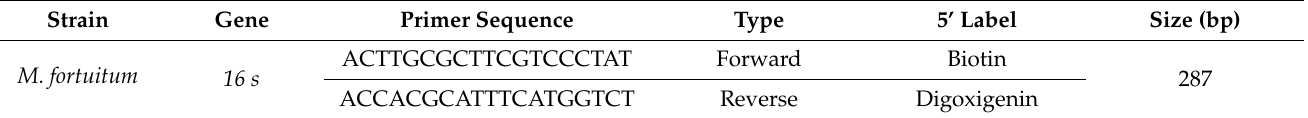
Table 1. Sequences of the set of primers for the double-tagging PCR amplification for the detection of M. fortuitum .